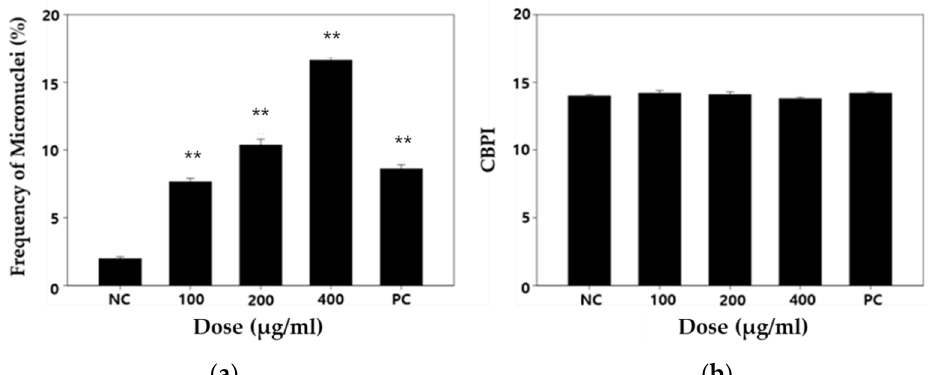
Figure 5. Measurement of ( a ) micronuclei frequencies and ( b ) cytokinesis block proliferation index (CBPI) in the diesel exhaust particles (DEP) treatment of the human lung embryo fibroblast (WI-38) cells. A statistically significant difference is indicated by ** p < 0.01 when compared with the negative control. Values are means of triplicate measurements. NC: negative control (0.2% DMSO); PC: positive control (0.4 µg/ mL mitomycin C).